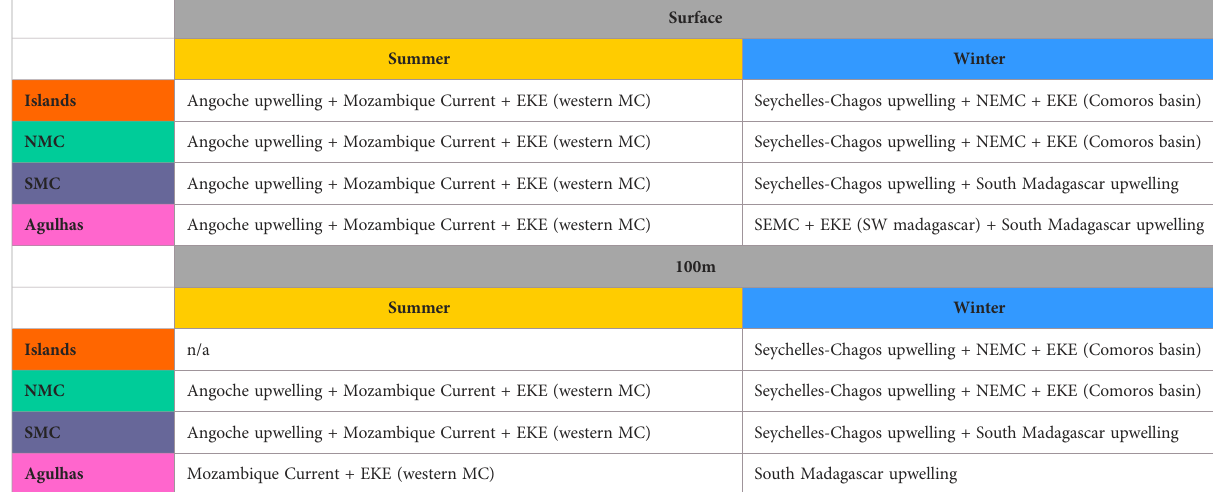
TABLE 2 Summary of the main drivers of thermal front seasonal variability in the Mozambique Channel, at surface and -100